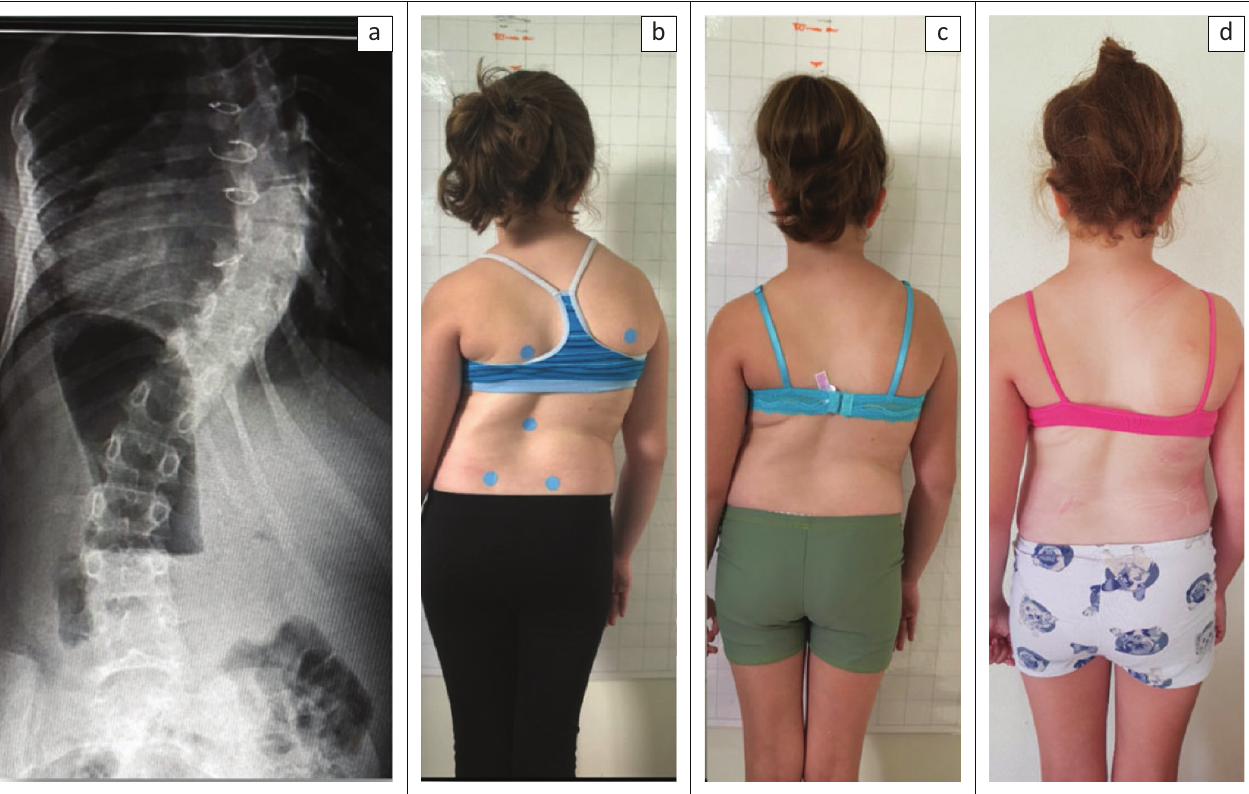
FIGURE 2: The patient with two operations for congenital heart disease with a collapsing spine at the age of 9.9 years at the start of treatment. (a) X-ray taken on November 2019 with a Cobb angle of approximately 65° Cob, (b) picture from the same time showing the patient from the rear with a collapsing spine, (c) after the application of the Schroth Best Practice Programme whilst waiting for the brace and (d) after a few nights spent in the